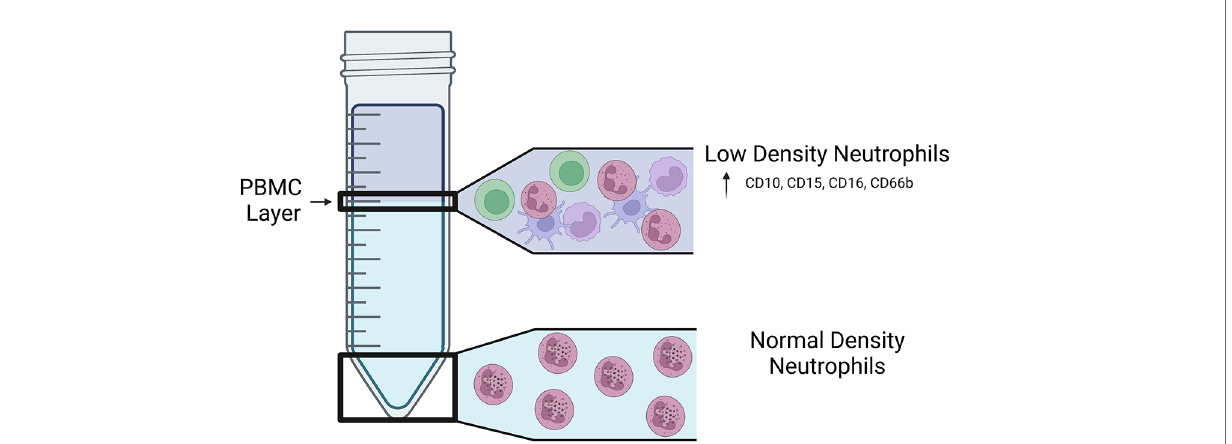
FIGURE 1 | Location of LDNs and NDNs following density centrifugation. Visual representation of the fractions in which LDNs and NDNs are found on a Ficoll- Hypaque gradient. LDNs are found in the lower density PBMC layer of a Ficoll-Hypaque gradient and express increased CD10, CD15, CD16, and CD66b on their